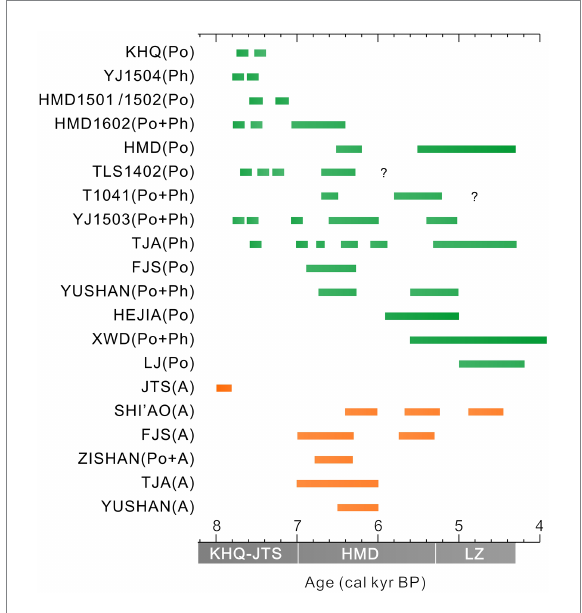
FIGURE 7 Collected information on the rice planting history (including cultivation and domestication) in the YJV. The horizontal axis represents the age of the occurrence of rice planting revealed in different sediment cores or archaeological sites. The vertical axis represents the cores or sites with rice planting history. “Po” represents evidence of rice planting supported by pollen records. “Ph” represents phytolith evidence and “A” represents archaeological findings. “JTS” represents JTS occupation. “KHQ” represents Kuahuqiao Culture. “HMD” represents Hemudu Culture. “LZ” represents Liangzhu Culture (The relevant data came from Wang and Zhang, 2001; Zhejiang Provincial